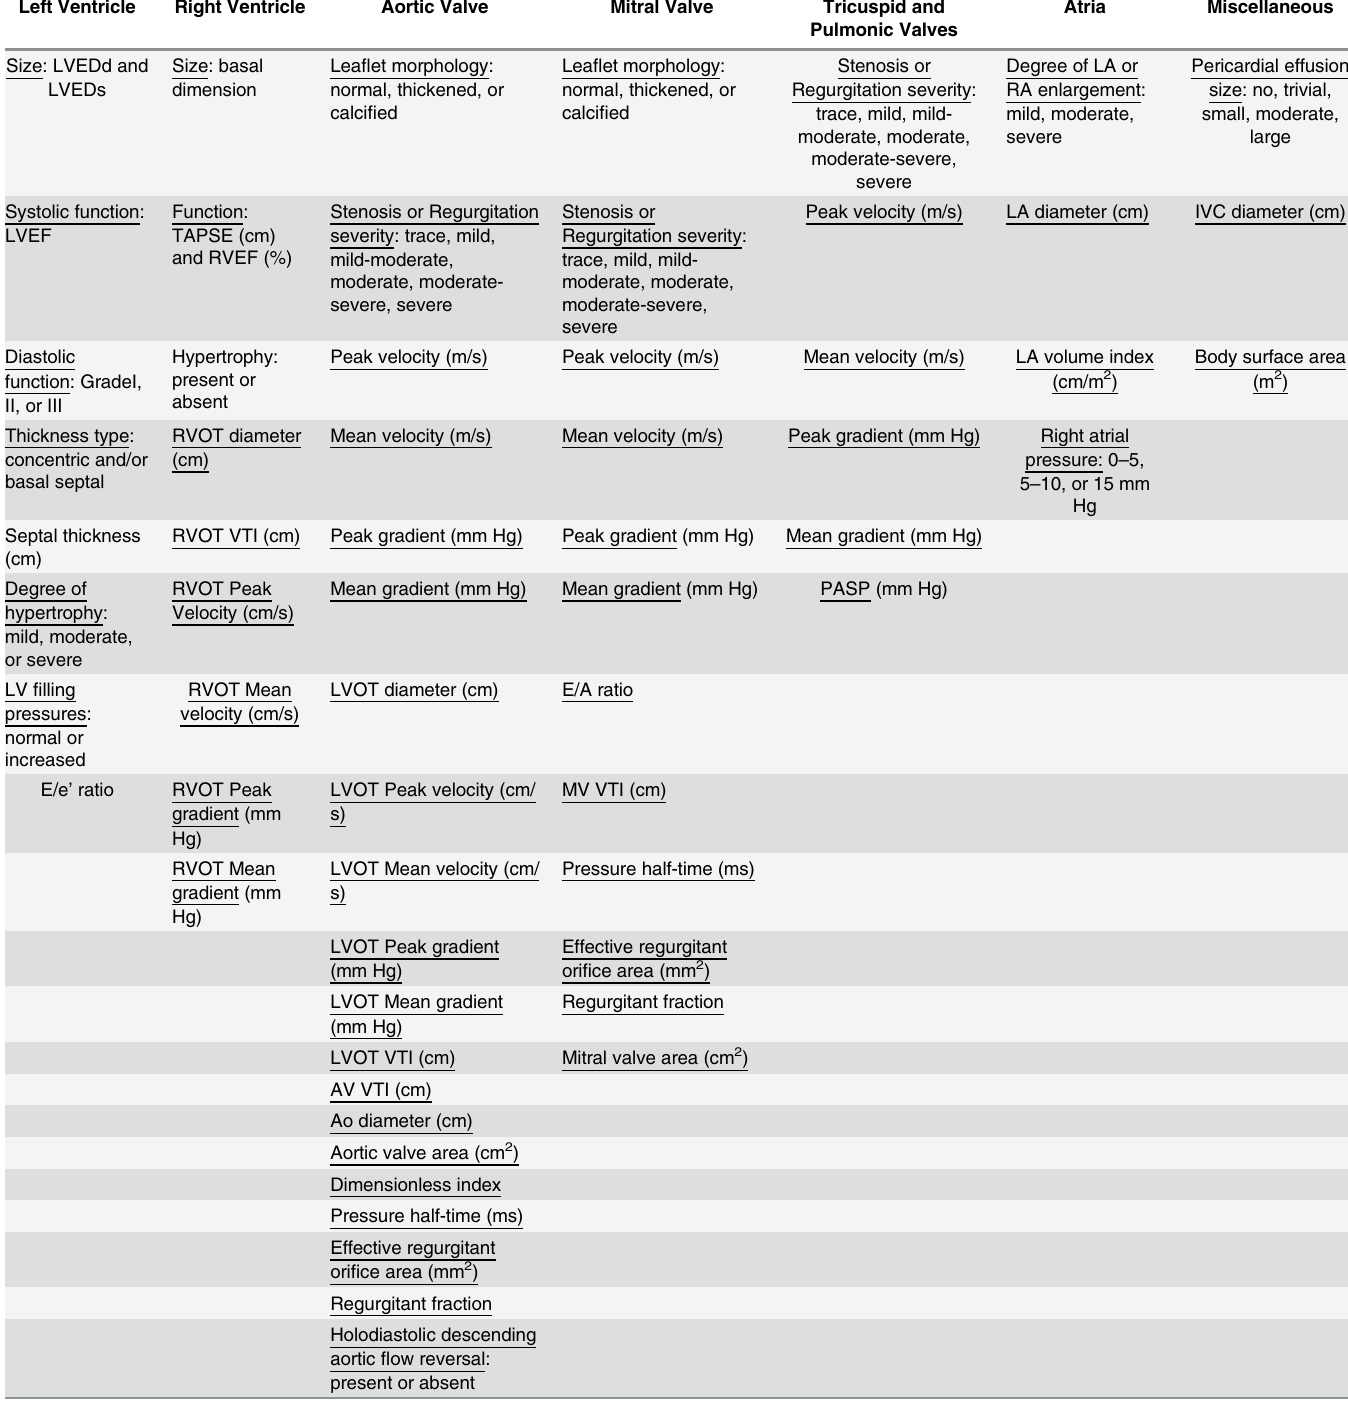
Table 1. List of EchoInfer data elements targeted for extraction. Left Ventricle Right